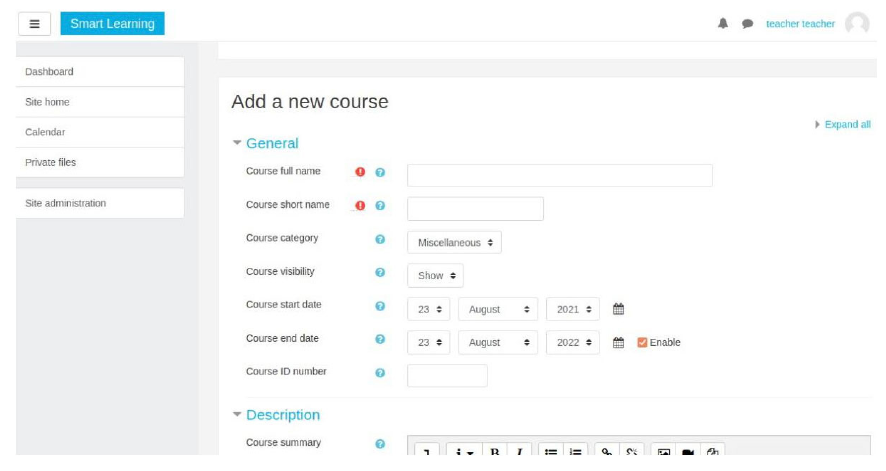
Fig. 5. Add a new